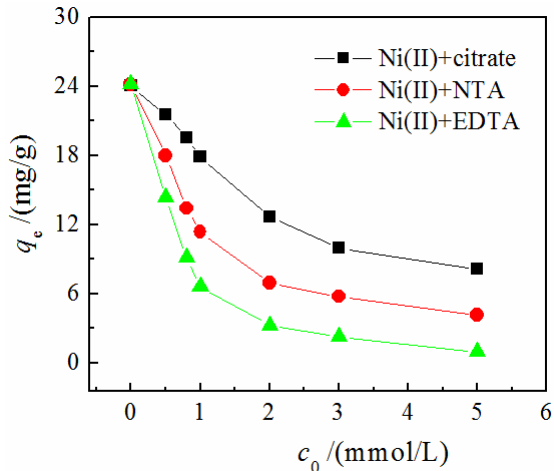
Figure 4. Effect of the coexistent complexing reagents on Ni(II) adsorption. c 0 (Ni(II)) = 1.0 mmol/L; t : 360 min; membrane amount: ~0.2 g; T : 298 K; pH: 5.4.